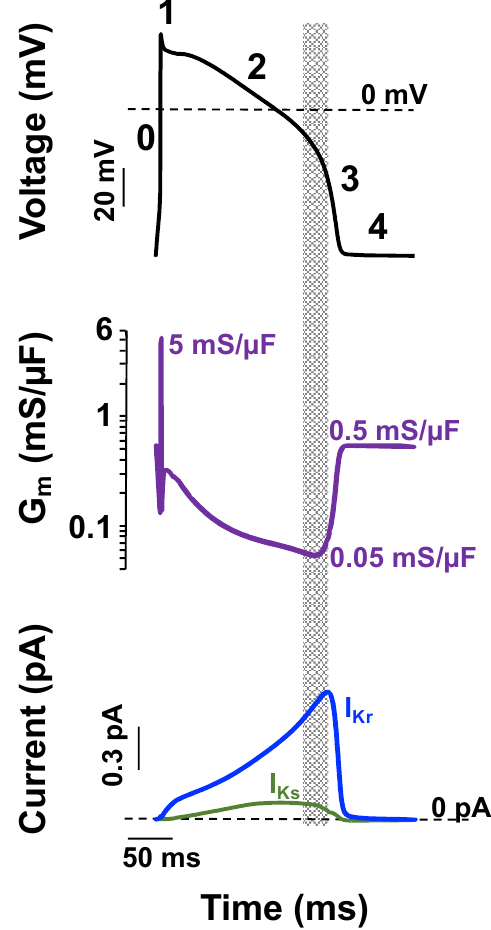
Figure 2. Small I Ks and I Kr can drive ventricular action potential repolarization and contribute to repolarization reserve because of low membrane conductance. Shown is a computational simulation for the change in membrane potential using the Soltis–Saucerman ventricular myocyte AP model [63] for normal conditions (37 ◦ C and 5.4 mM extracellular [K + ], black traces) driven at 1 Hz (upper panel). The phases of the AP are numbered (0–4). The middle panel shows the corresponding changes in membrane conductance (G m ) , and the bottom panel shows the corresponding I Ks (green line) and I Kr (blue line). The dashed lines represent 0 mV or 0 pA levels in V m and macroscopic current recordings, respectively. The start of the rapid repolarization phase occurs when G m is at its lowest value and I Ks and I Kr are near their maximal values (shaded region).